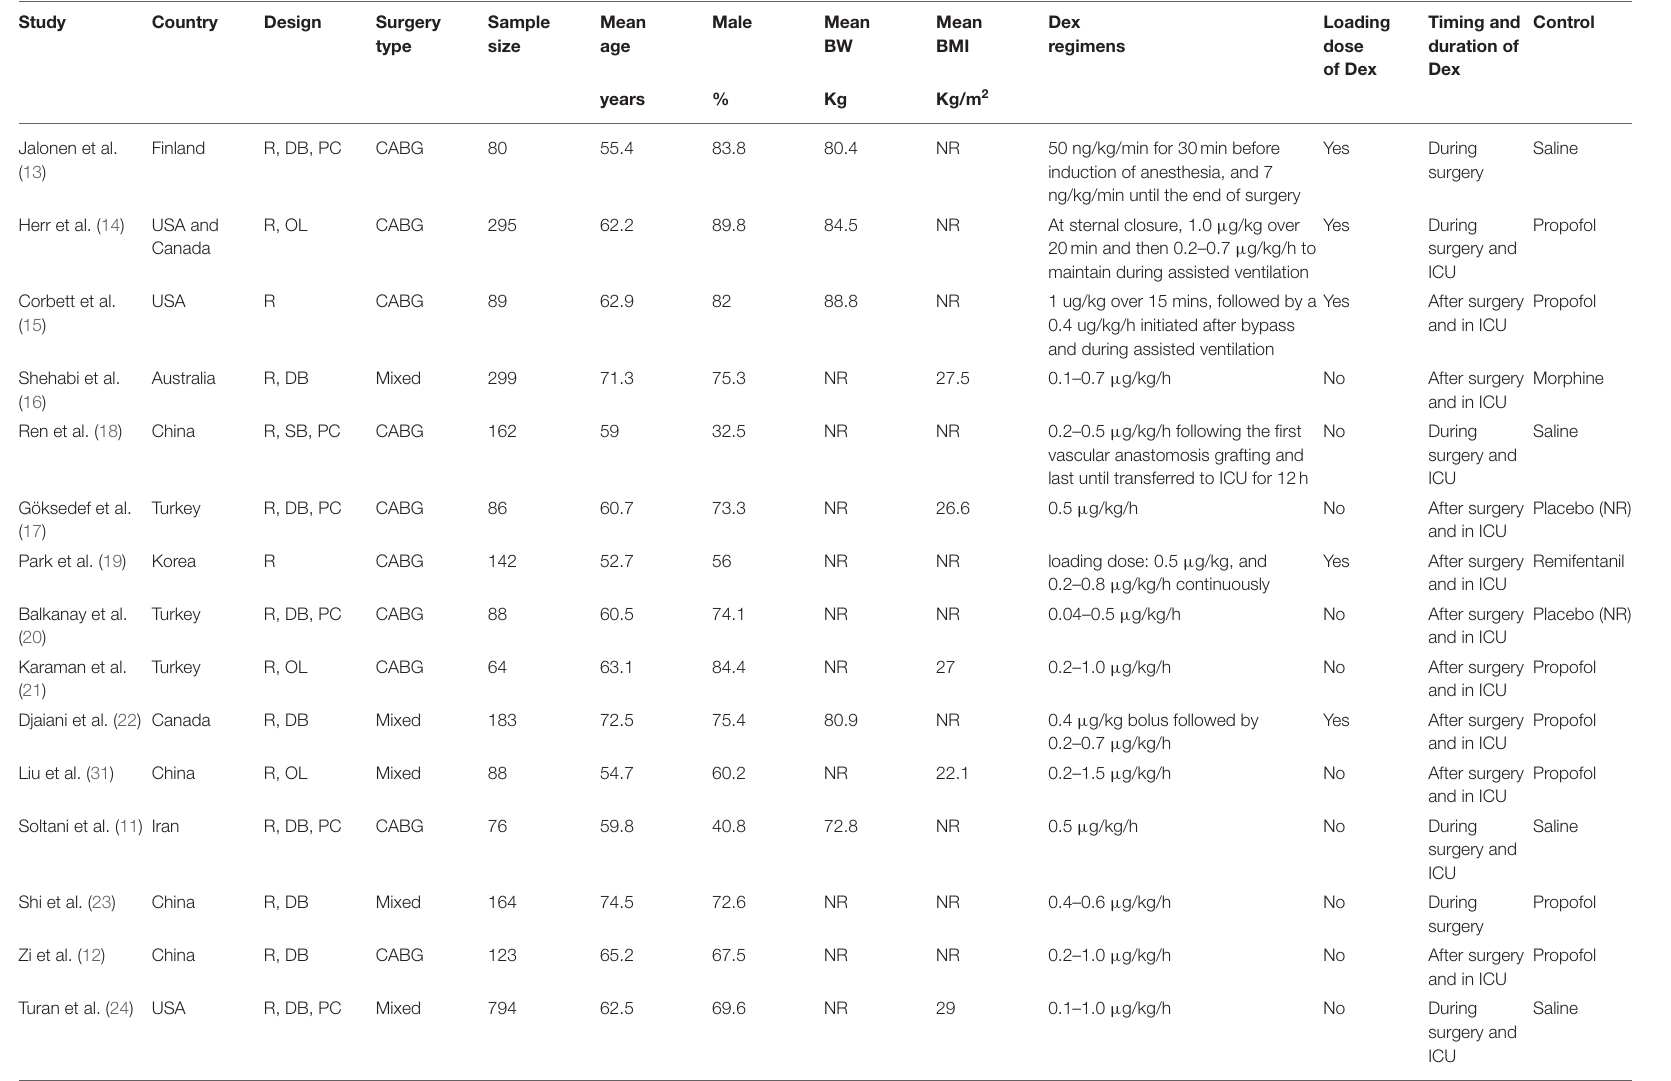
TABLE 1 | Characteristics of the included clinical